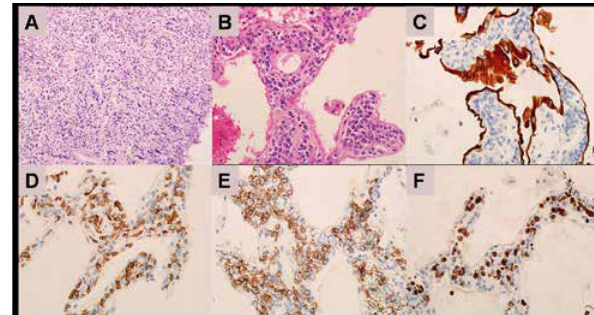
Figure 3: Hematoxylin and eosin (H&E) staining and immunohisto- chemical staining. A: Alveolar septal broadens, and tumor cells infil-